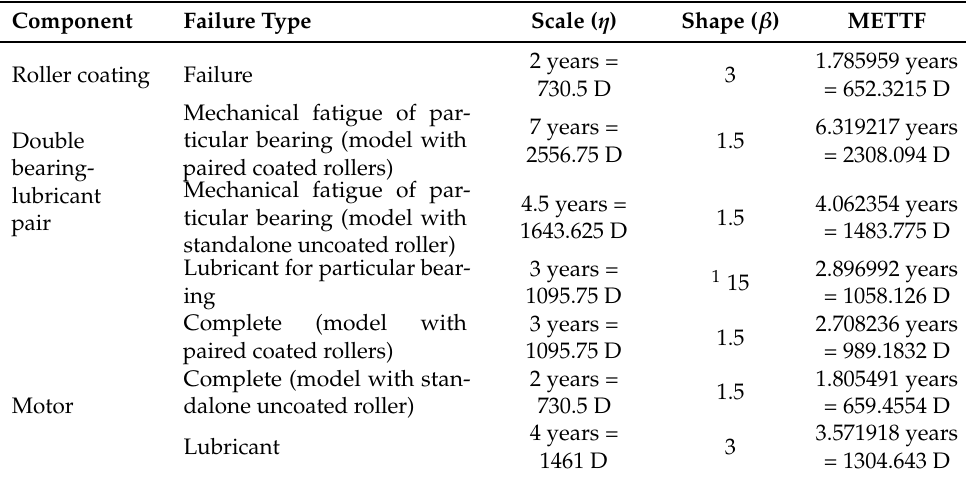
Table 17. ETTF distribution parameters and METTF for the models discussed in this paper for the bleaching machine